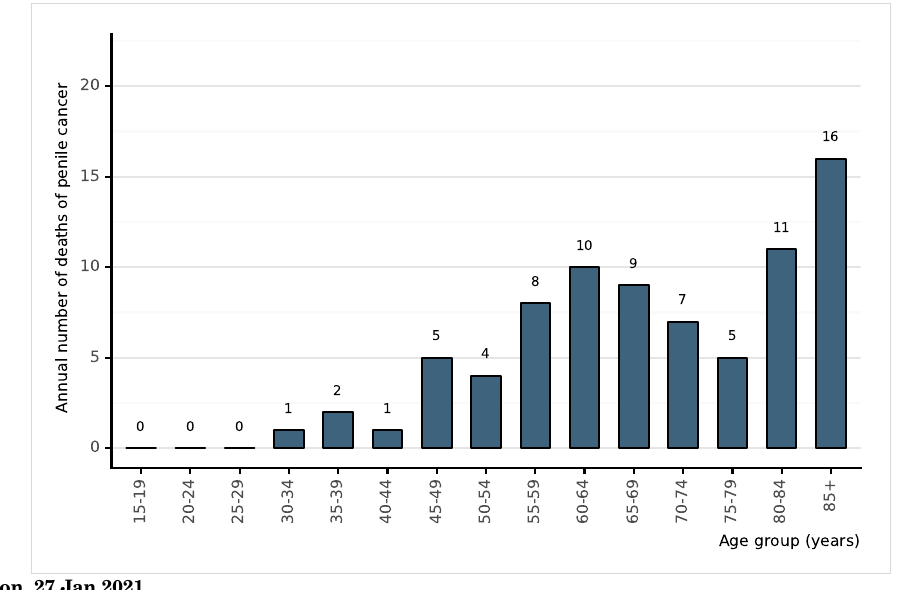
Figure 34: Annual number of deaths of penile cancer in Peru (estimates for